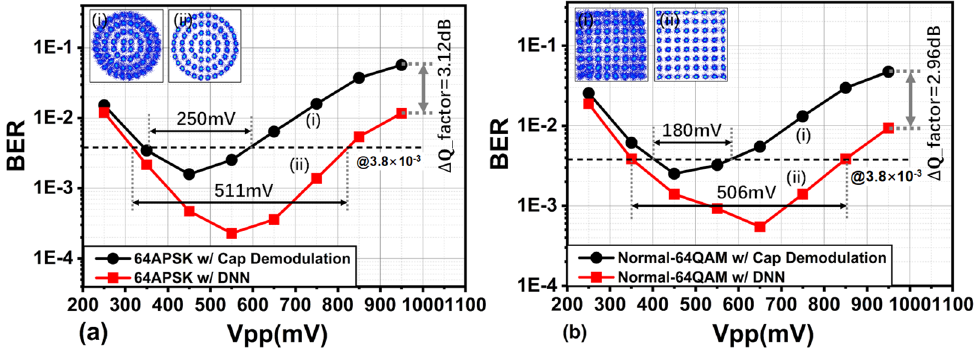
Figure 7. BER versus different Vpp for ( a ) 64APSK; ( b ) 64QAM UVLC systems.